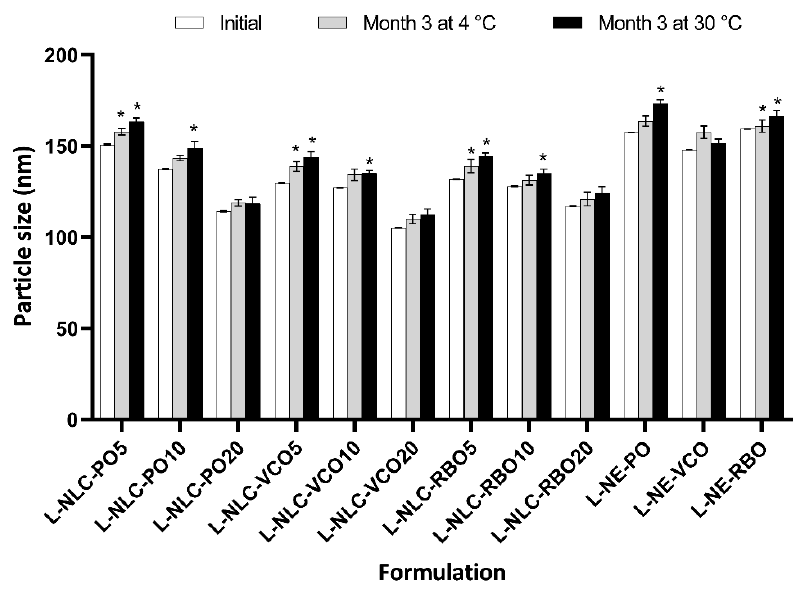
Figure 4. Particle size of lutein-loaded lipid nanocarriers after production (day 0) and after storage for 3 months at 4 °C and 30 °C. * Statistically significant difference comparing day 0 and 3 months of storage ( p < 0.05).